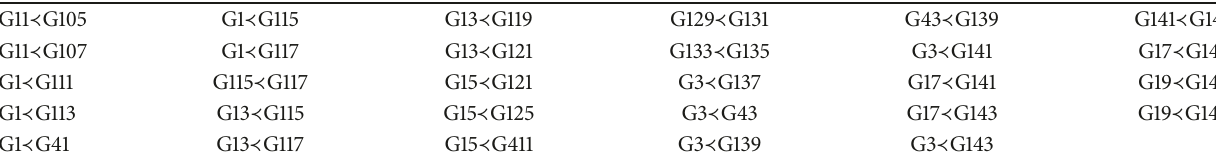
Table 2: The precedence relationship.